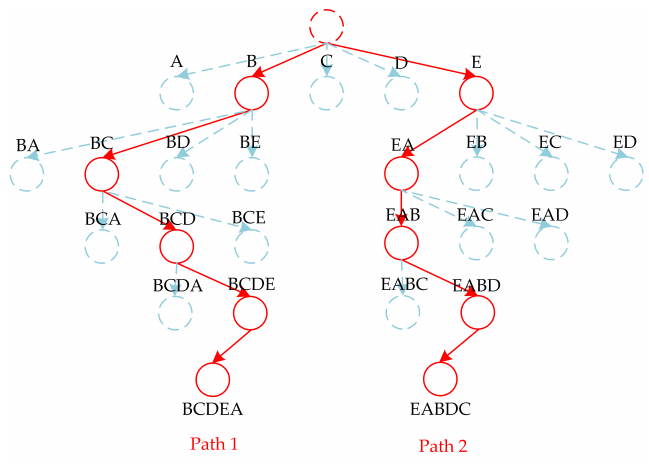
Figure 9. Beam search with beam width equal to